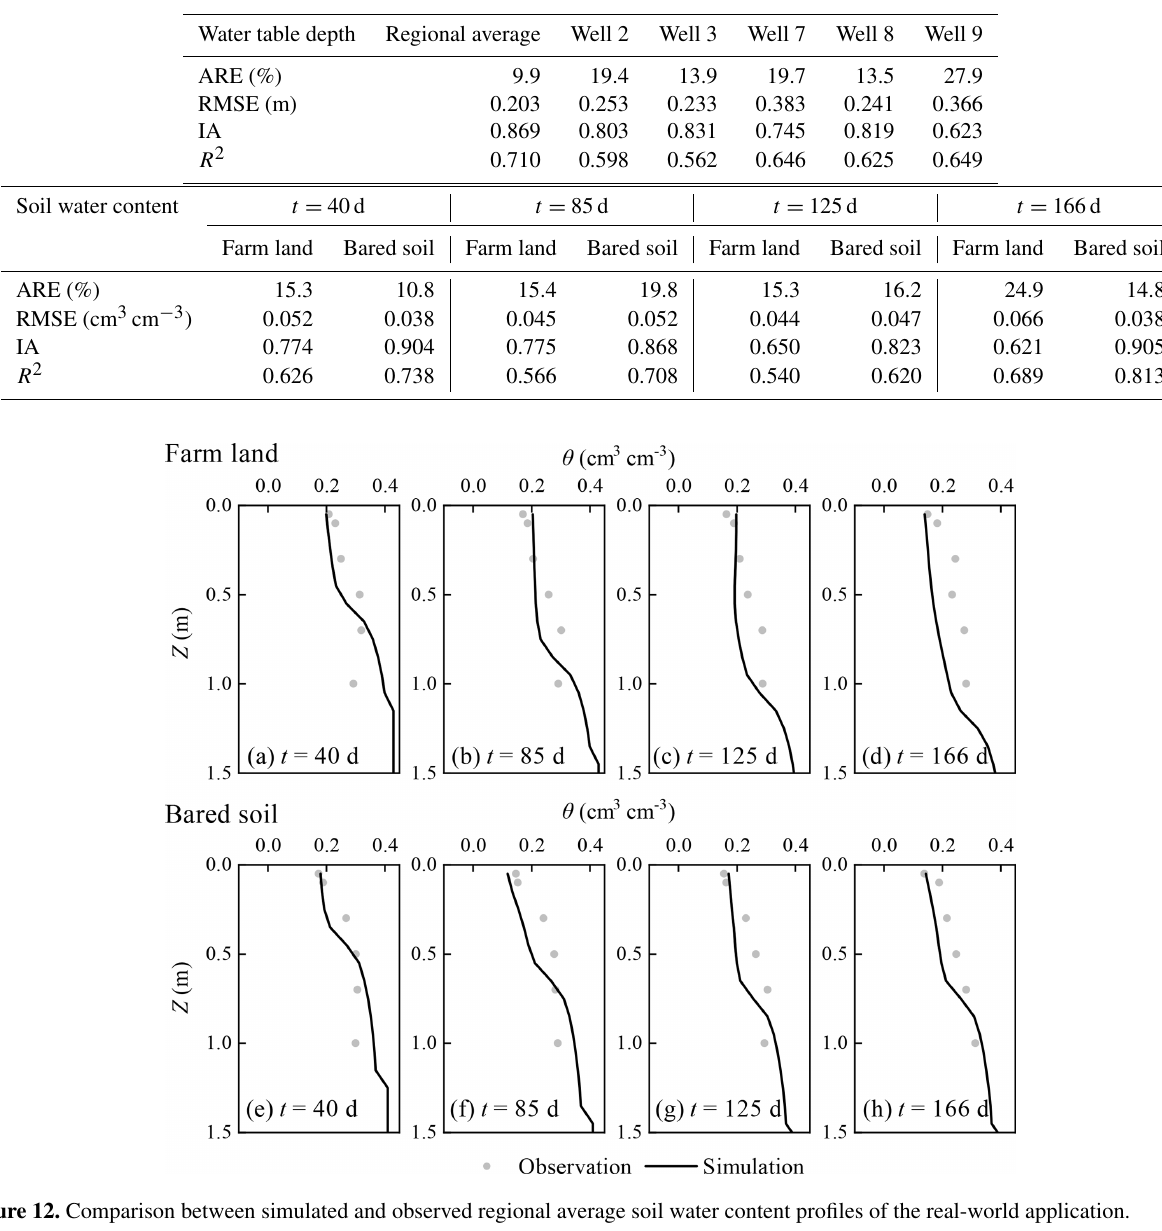
Table 5. The statistical index values of the real-world application.